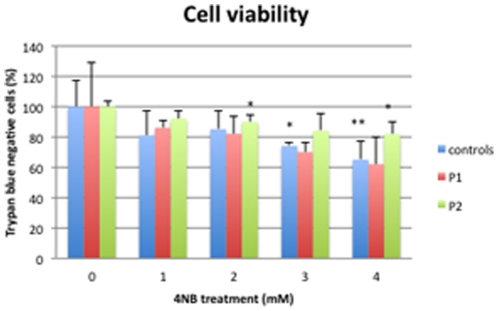
Trypan blue staining in control (n = 5), P1 and P2 skin fibroblasts after 4-NB treatment.The values are expressed as percentage of controls, P1 and P2 after 4 mM DMSO treatment. (* P<0.05 vs. controls; ** P<0.01 vs. controls).